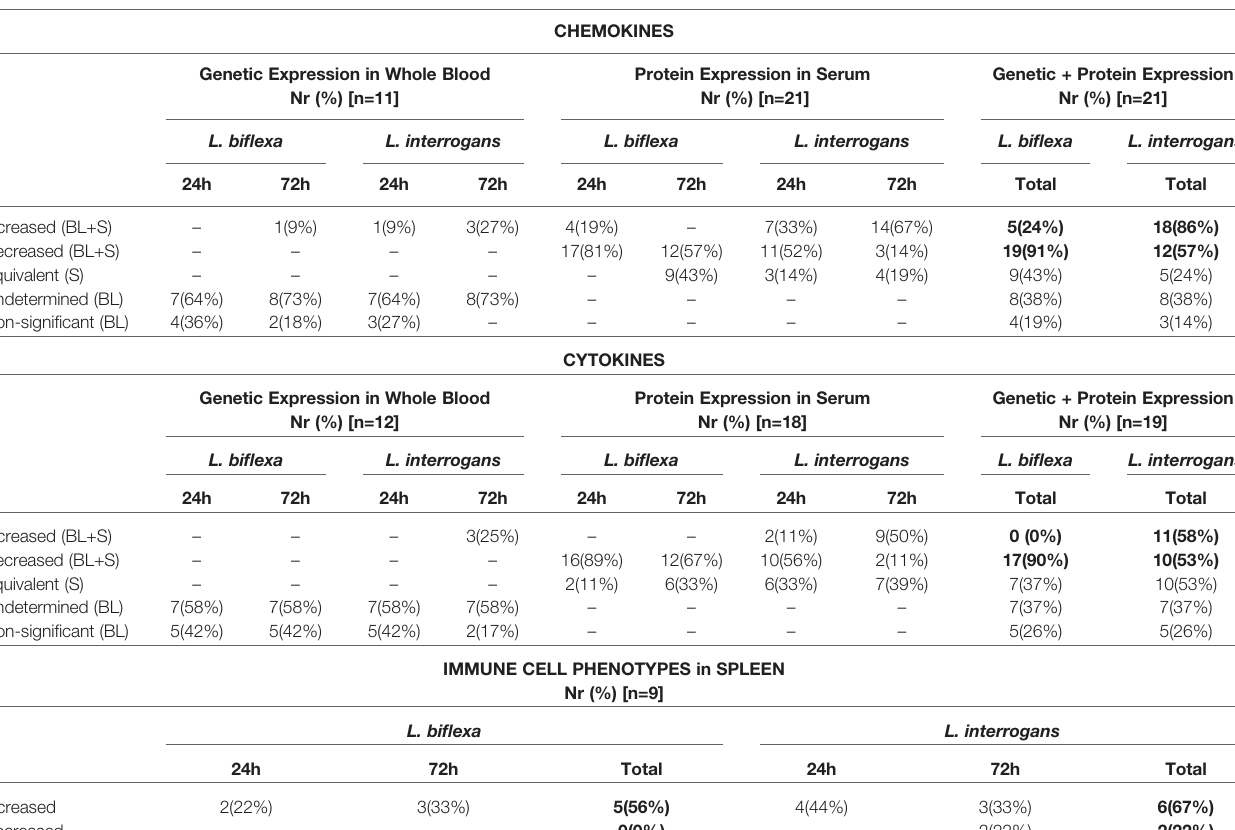
TABLE 4 | Summary of immune markers and cells involved in responses to L. bi fl exa and L. interrogans